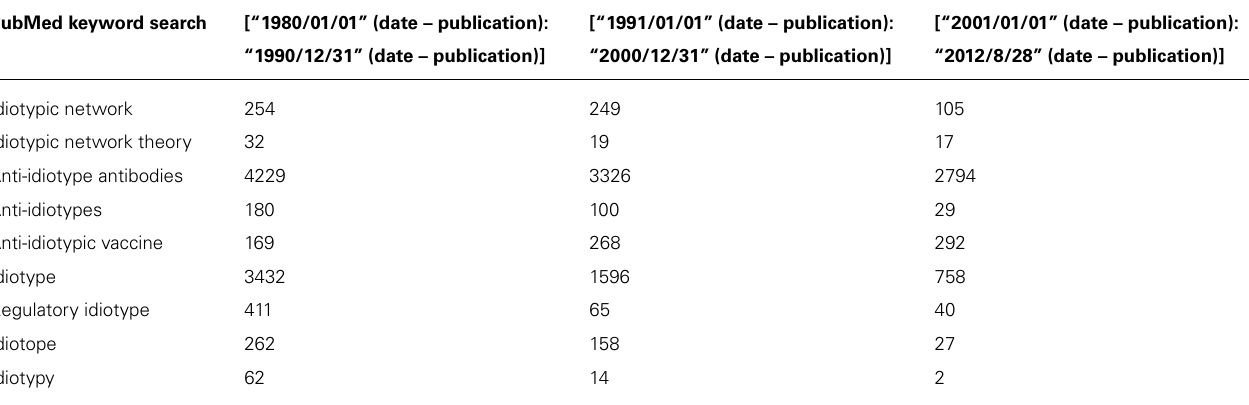
Table 2 | Distribution of publications based upon keywords associated with the network